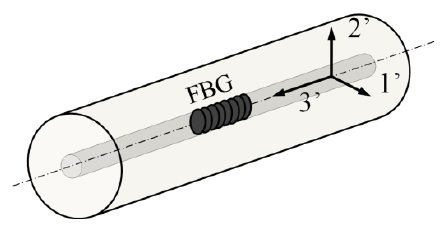
Figure 2. The used coordinate system of an optical